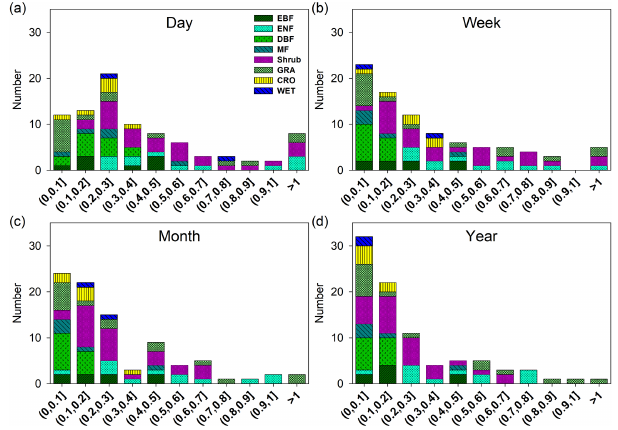
Figure 6. Distribution of the key parameter c at the daily scale (a) , weekly scale (b) , monthly scale (c) , and yearly scale (d) . EBF, ever- green broadleaf forests (8); ENF, evergreen needleleaf forests (27); DBF, deciduous broadleaf forests (13); MF, mixed forests (5); shrub (12), closed shrubland, open shrublands, woody savannas, and sa- vannas; GRA, grassland (15); CRO, croplands (6); WET, permanent wetlands (2).